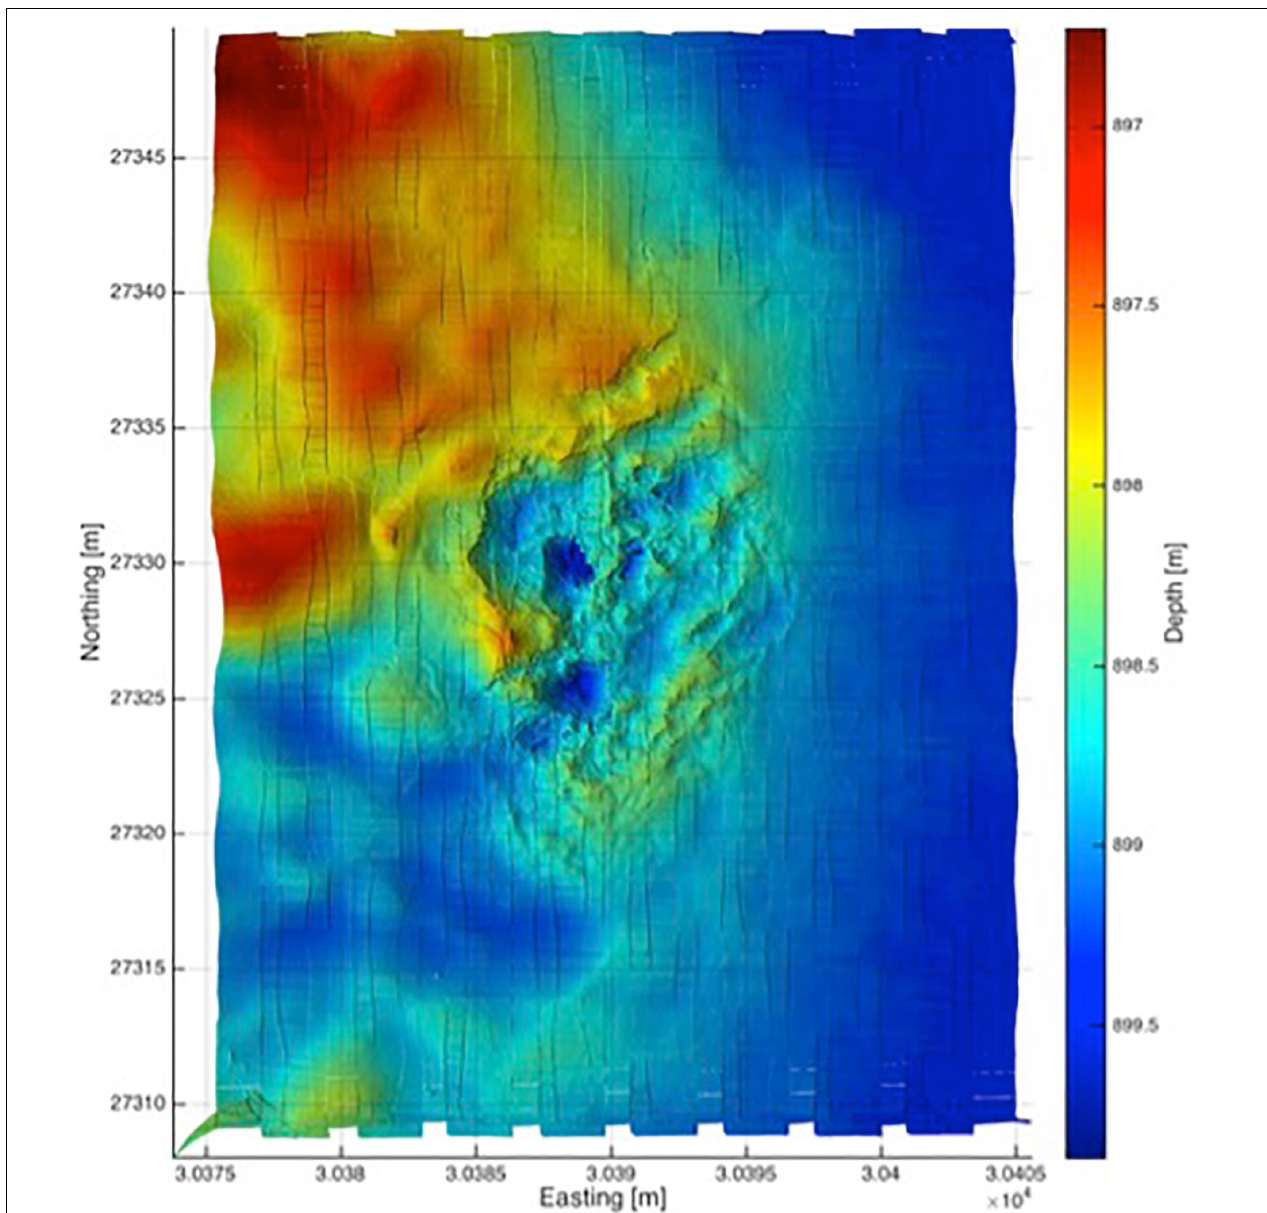
FIGURE 5 | High resolution bathymetric map of the Triton cold seep site. This map was created using structured light laser data, and gridded to 1-cm level resolution. Bathymetry was obtained while the ROV surveyed at 3 m above the seafloor. The bathymetric data shown here are co-registered with the photomosaic shown in Figure 4